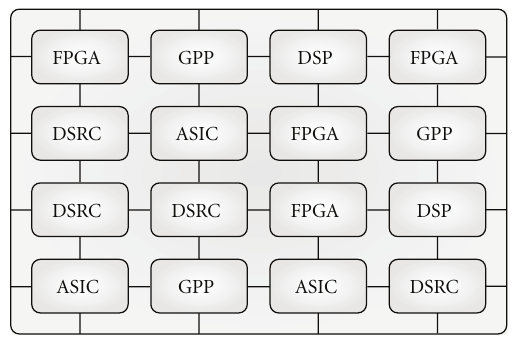
Figure 3: Heterogeneous tiled